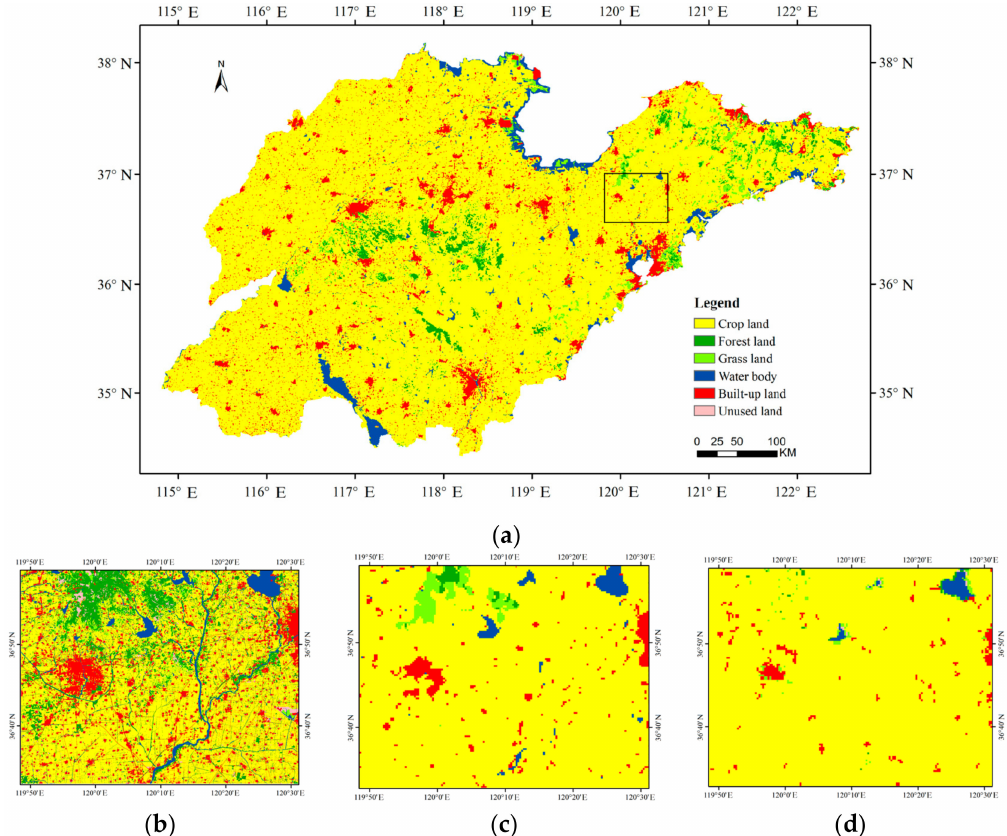
Figure 6. Land cover classification maps: ( a ) improved rotation forest results for Shandong Province; ( b ) sample area of truthing reference map; ( c ) sample area of improved rotation forest results; and ( d ) sample area for the NASA